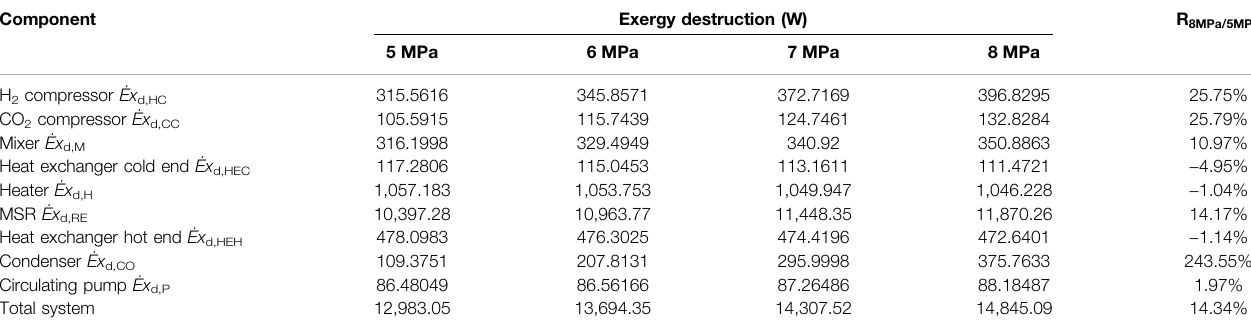
TABLE 3 | Exergy destructions in the CDHM system under different reaction pressures. Component